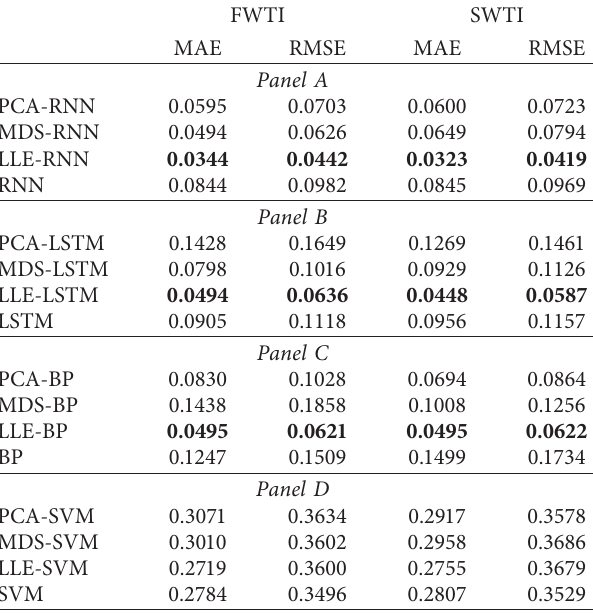
Table 8: Errors of benchmark and variant model.